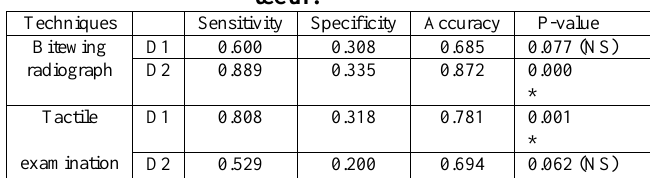
Figure 4: Receiver operator characteristic ROC plot: Tactile examination at dentin threshold for occlusal surface Table 1: The sensitivity, specificity, accuracy and p-value for diagnostic techniques to detect secondary caries at enamel (D1) and dentin (D2) threshold in occlusal surface in primary molars